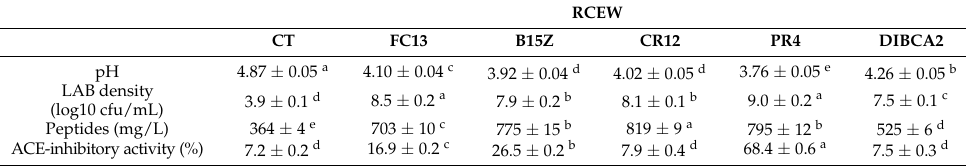
Table 1. Characteristics of the RCEW inoculated (7.0 log10 cfu/mL) with selected LAB.